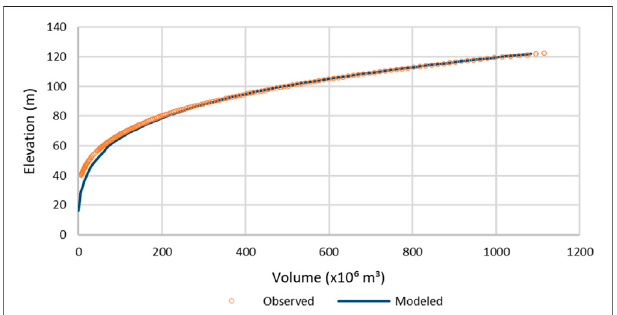
FIGURE 2 | Cumulative volume - water level